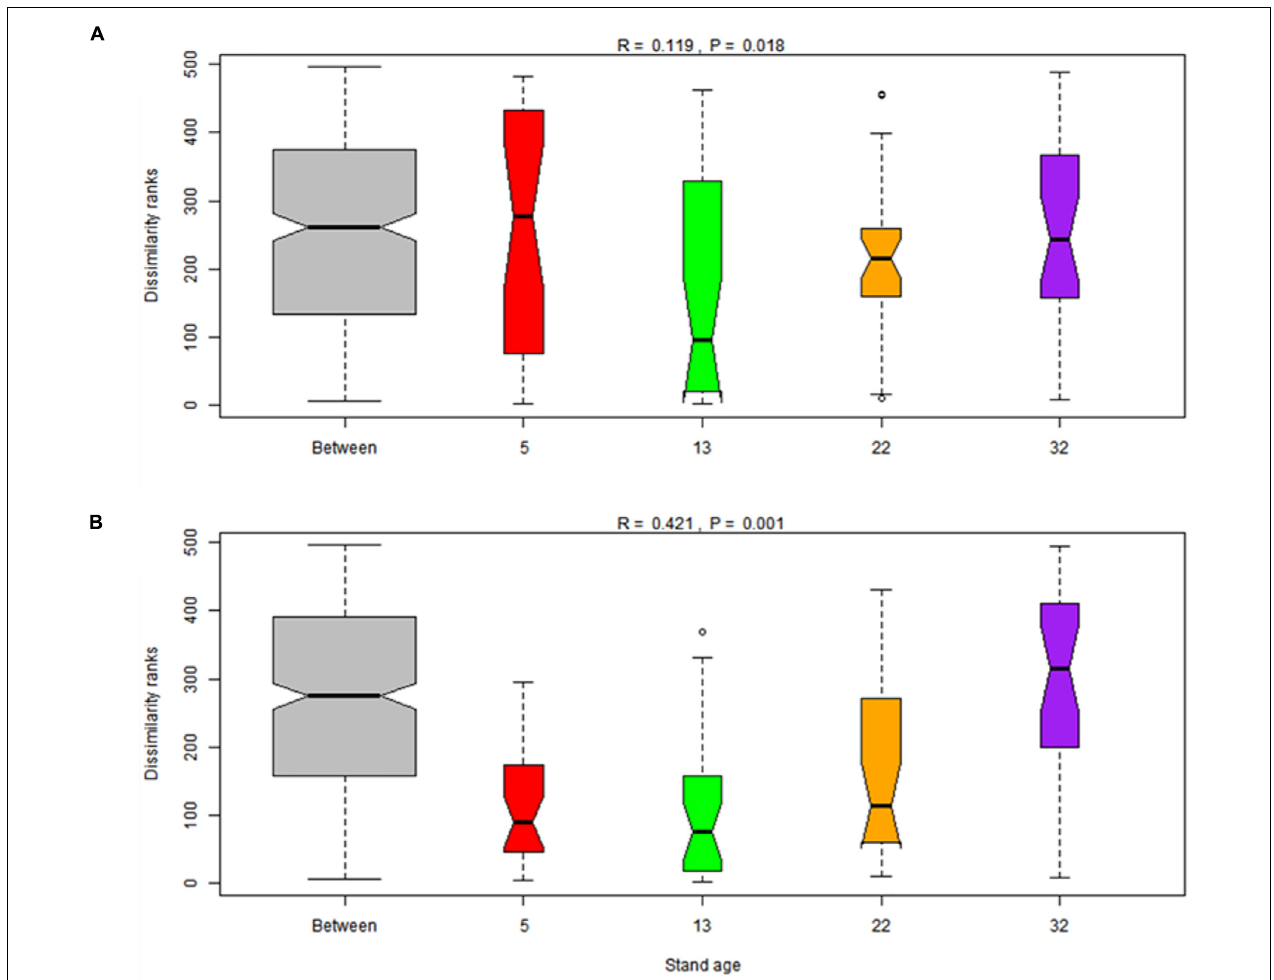
FIGURE 4 | Boxplot of analysis of similarities (ANOSIM) based on the Bray–Cutis dissimilarities of soil bacterial (A) and fungal (B) community among different stand ages (7-, 15-, 24- and 34-year-old stands) in Xinkou Forest Farm, Southeastern